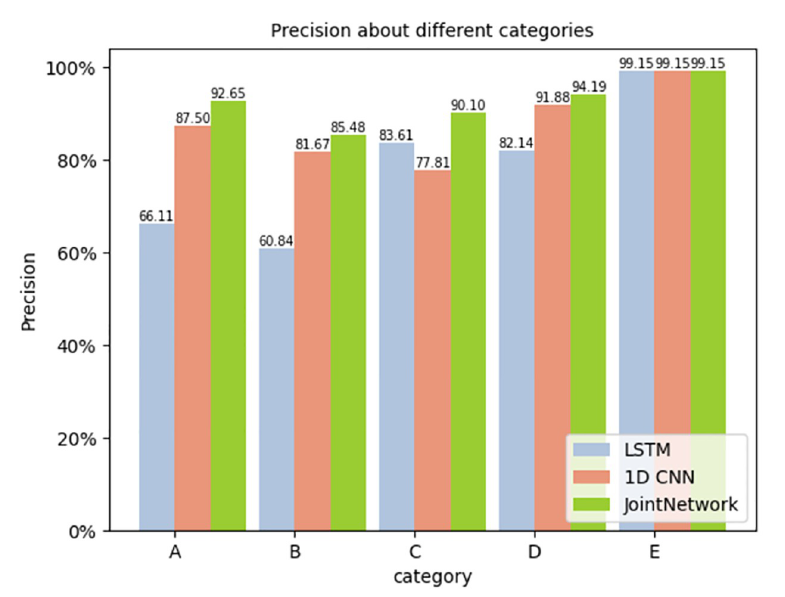
Fig 9. Precision about different